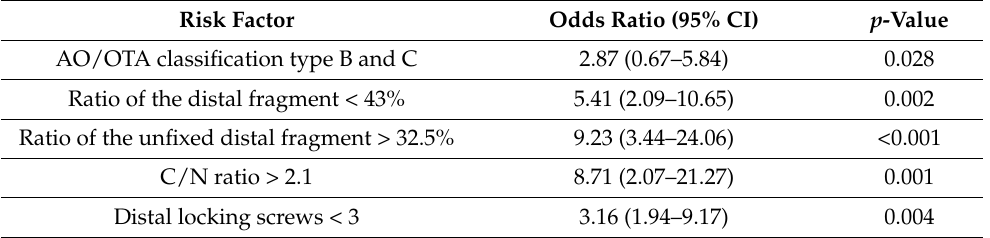
Table 3. Independent risk factors for non-union after antegrade nailing (multivariate analysis). Risk Factor Adjusted Odds Ratio (95% CI) p -Value AO/OTA classification type B and C Ratio of the distal fragment < 43% 0.018 Ratio of the unfixed distal fragment >